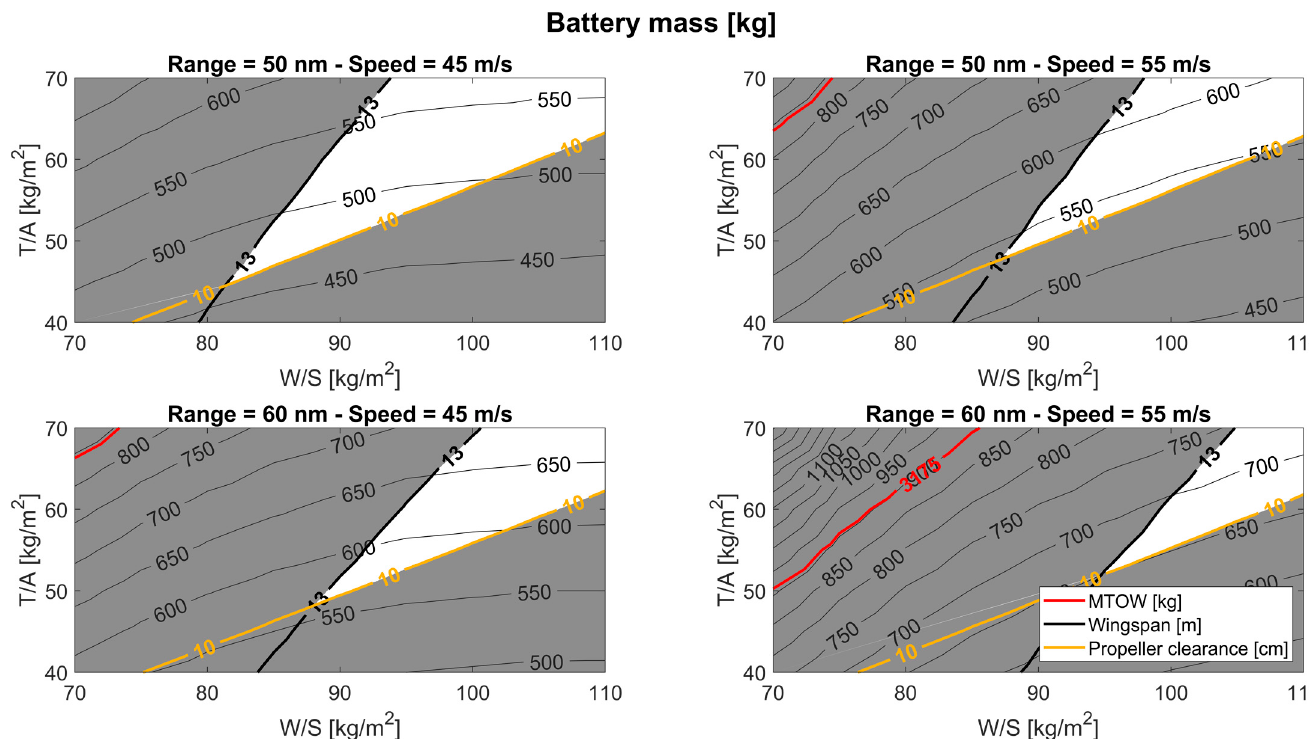
Figure 13. W/S vs. T/A charts of battery mass (current technology) varying speed and range. Each plot shows a highlighted area, which identifies the design space compliant with the constraints.